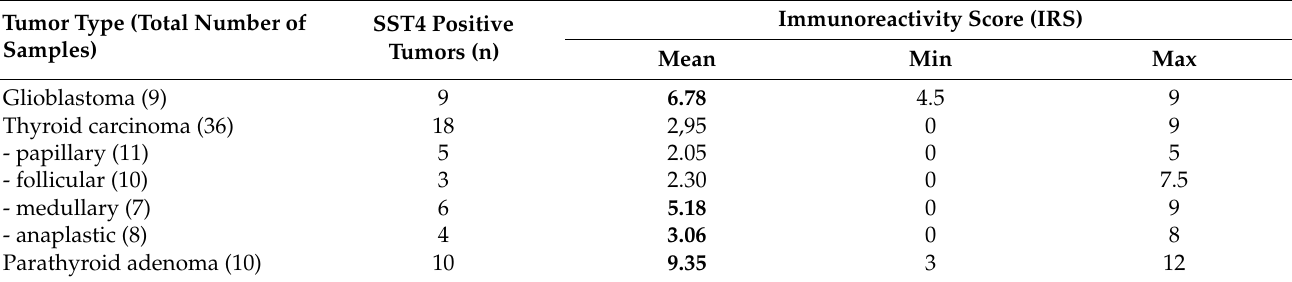
Table 1. Presence of SST4 in different human tumor samples. Mean IRS values ≥ 3.0 are marked in bold. Min: minimum values; Max: maximum